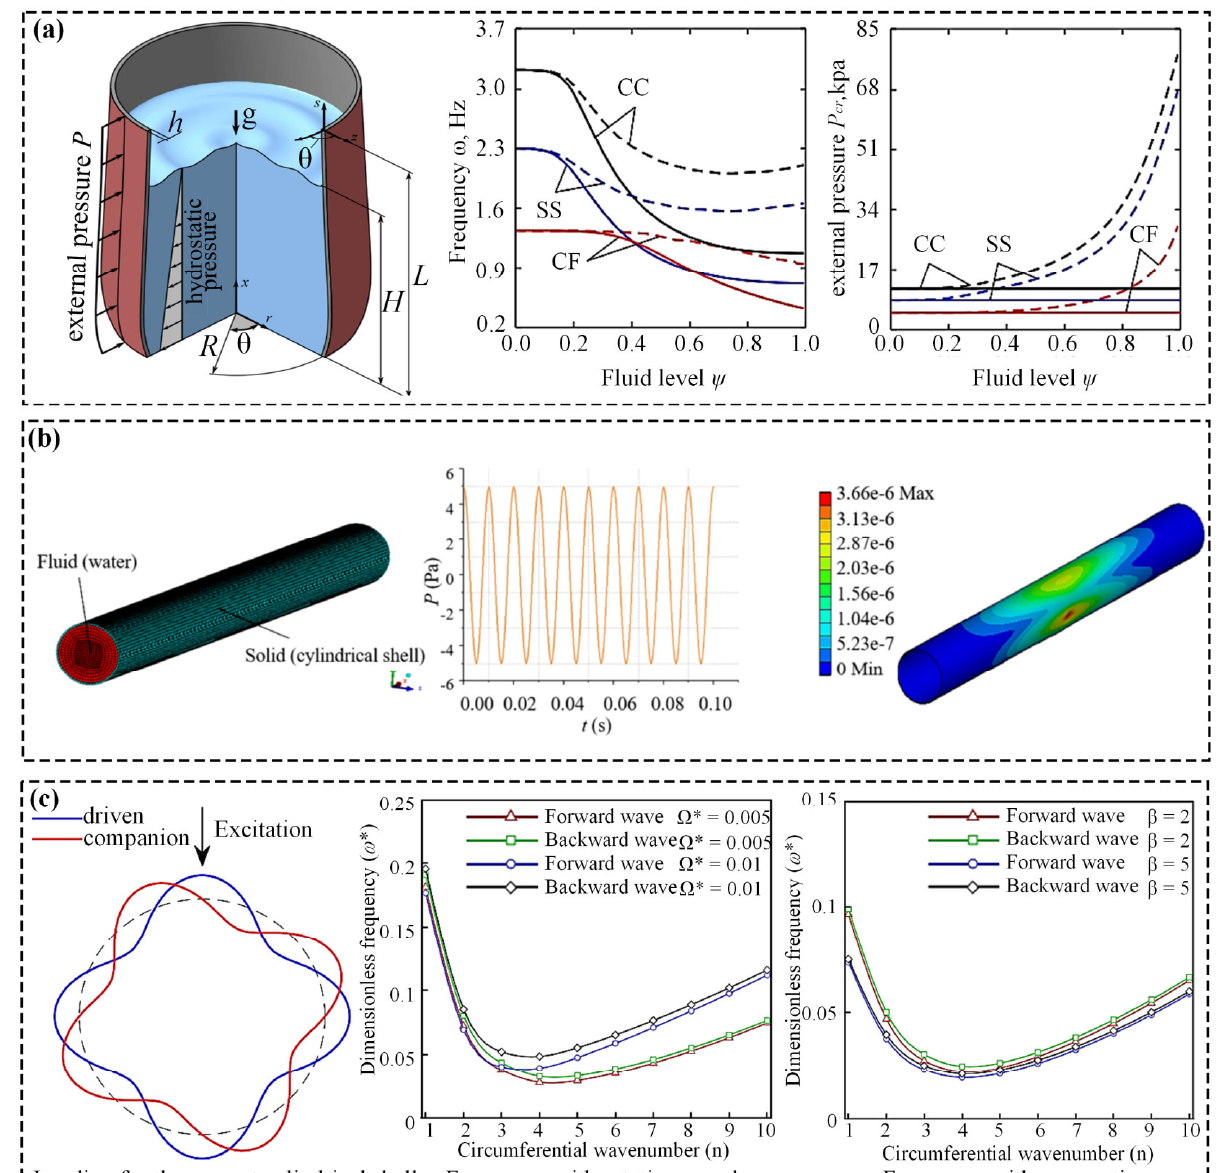
Figure 12. Vibration characters of the fluid–solid-based thin-walled shell. ( a ) Dependencies of natural frequencies and external pressures. (Reprinted with permission from Ref. [100]. 2012, John Wiley and Sons). ( b ) Cylindrical shell model and its stress feature. (Reprinted with permission from Ref. [103]. 2021, Elsevier). ( c ) Frequency response of the cylindrical shell under excitation. Reproduced with the permission of Elsevier. (Reprinted with permission from Ref. [104]. 2022, Elsevier.)